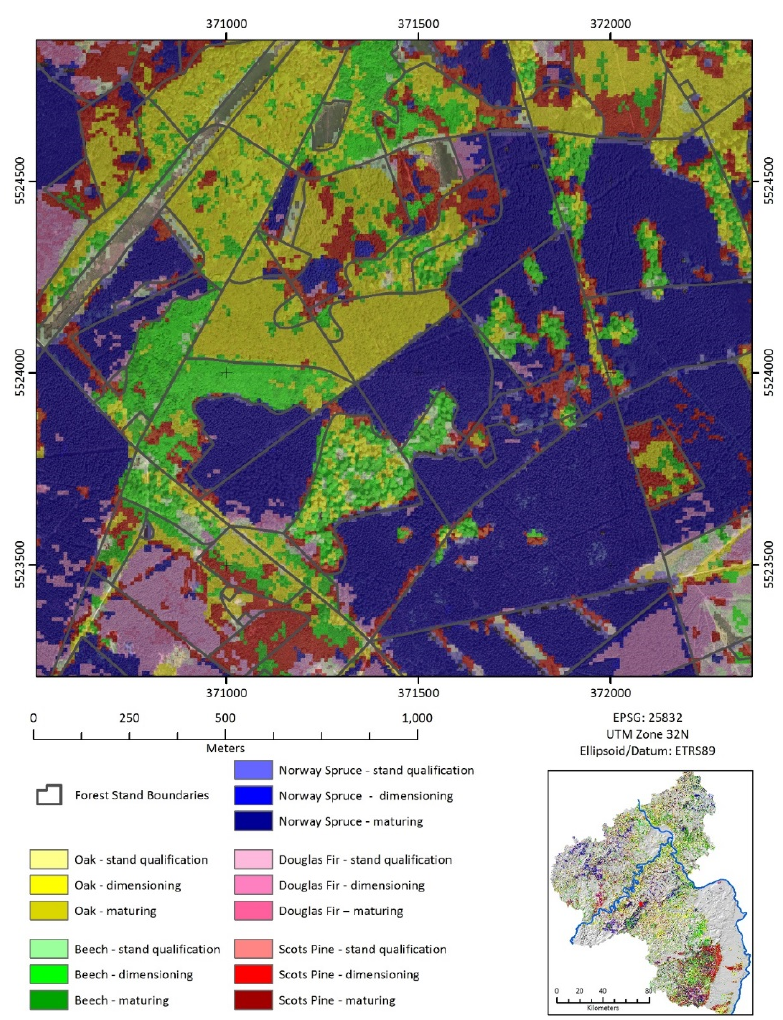
Figure 7. Subset of resulting state-wide forest information layer on tree species distribution and development stages, superposed by official forest stand boundaries and with high-resolution aerial imagery as background